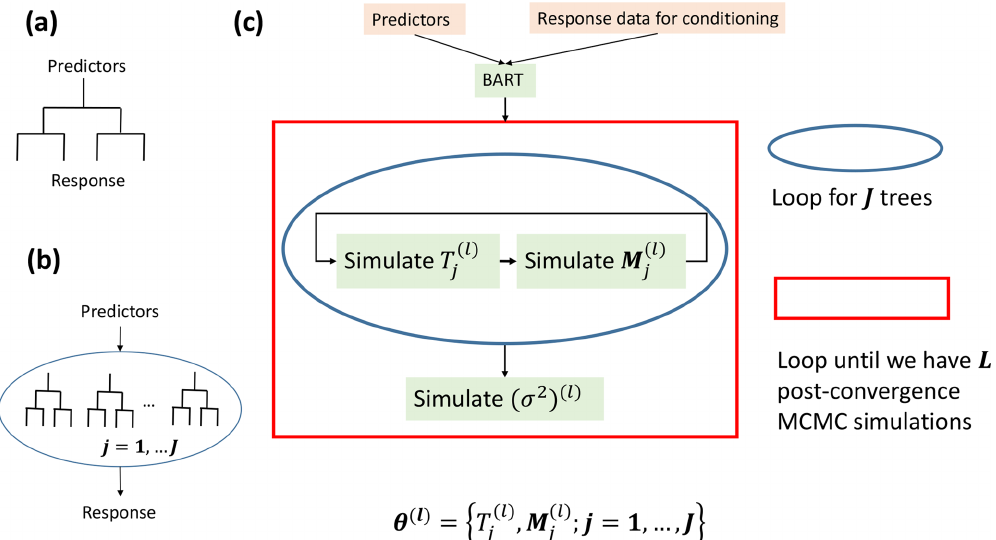
Figure 1. Schematic diagrams of (a) a regression tree model, (b) an ensemble tree model which consists of J additive regression tree models, and (c) the loops structure that BART uses to draw MCMC simulations (indexed by l ), consisting of an inner loop for J additive regression tree models and an outer loop that continues until we have a total of L MCMC simulations after convergence toward a stationary